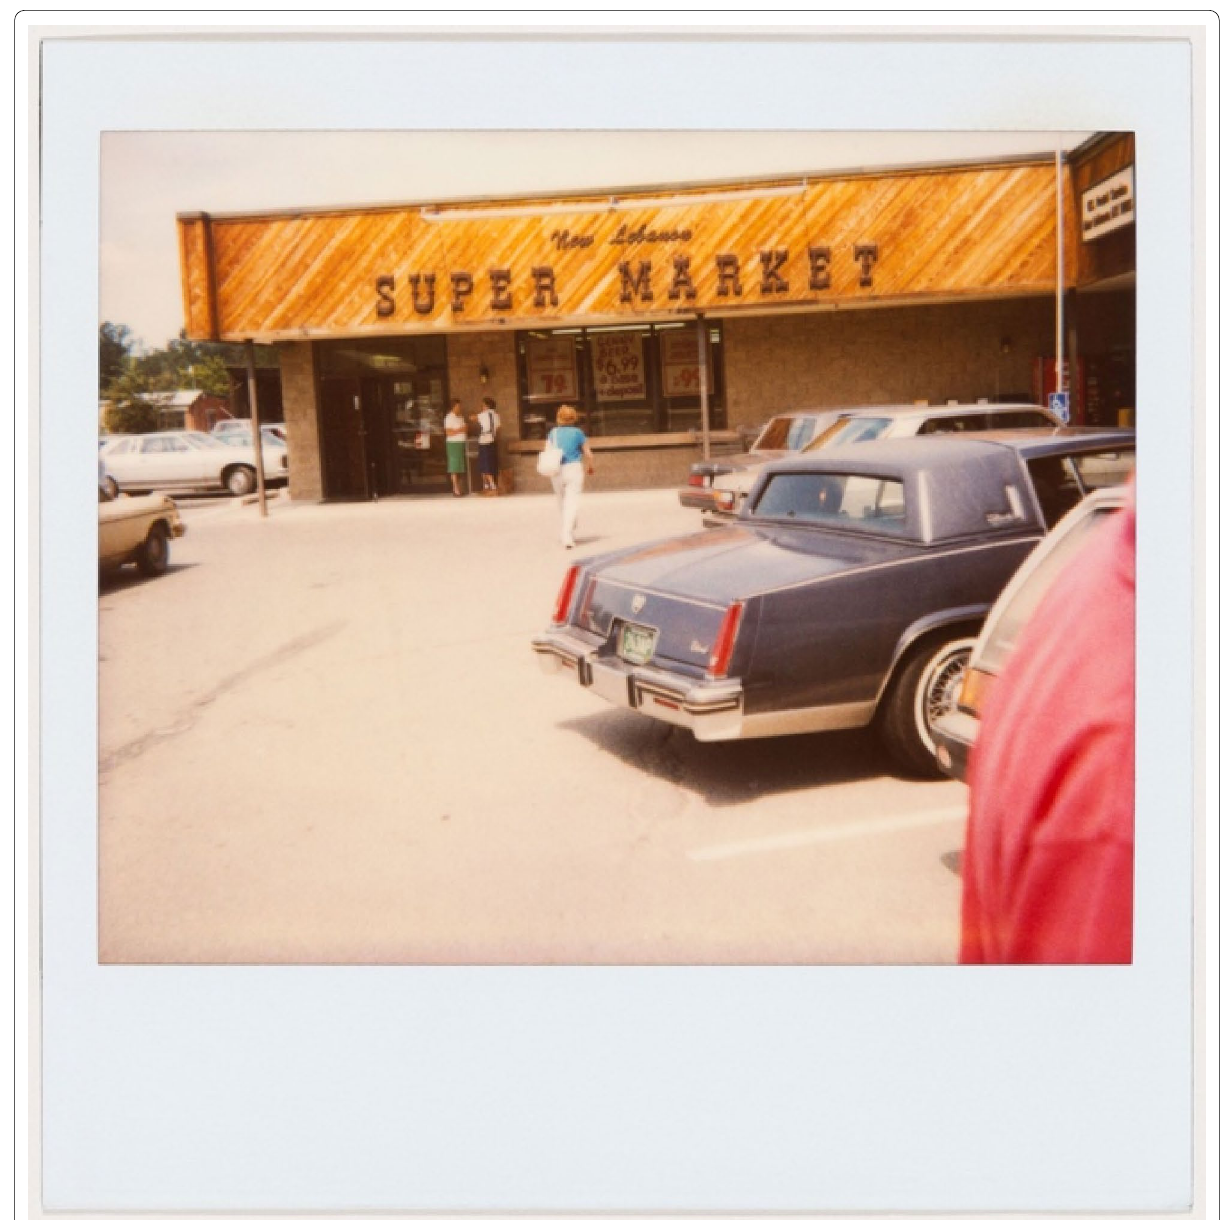
Fig. 10 Facade of the New Lebanon Supermarket, Massachusetts, United States, 1980s–1990s. Polaroid Photograph by Aldo Rossi. Credits: Aldo Rossi fonds, Canadian Centre for Architecture (CCA), Fondazione Aldo